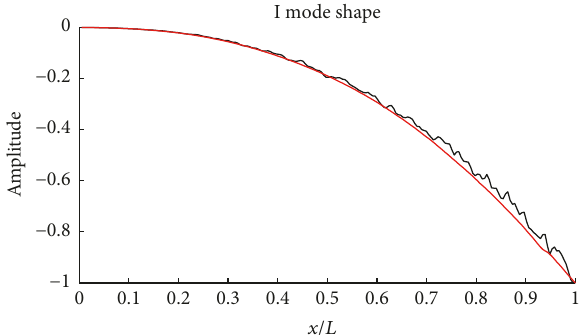
Figure 9: The first mode of blade natural vibrations measured experimentally: FFT (black) and FastScan (red).